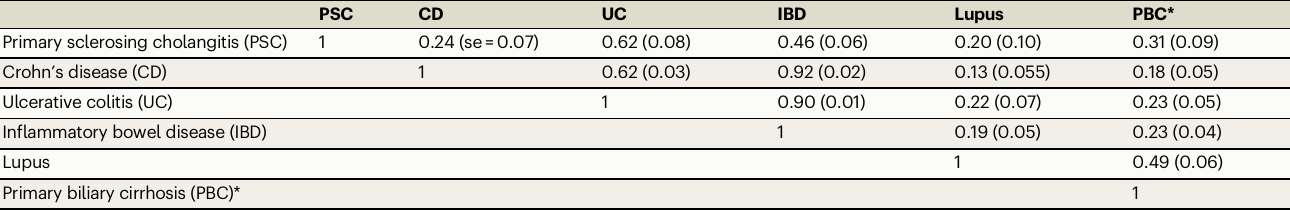
Table 1 | Estimate of genetic correlation among autoimmune-related